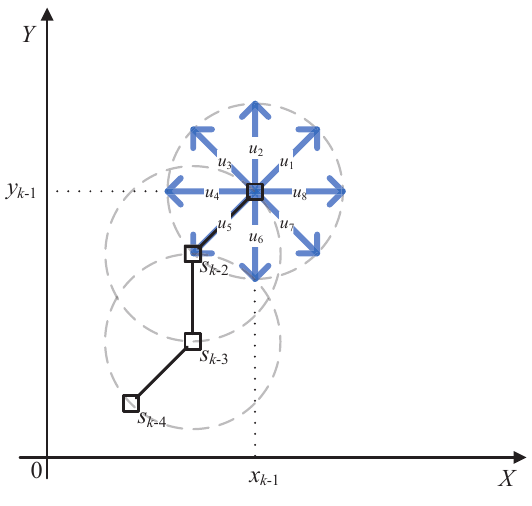
Figure 2. The trajectory of a sensor using ICP. The black denotes the position of the sensor; the blue → denotes admissible control actions; and the black solid line denotes the